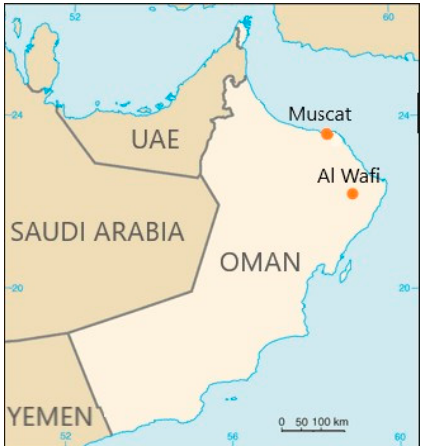
Figure 1. A map showing the location of Muscat city and Al Wafi village.